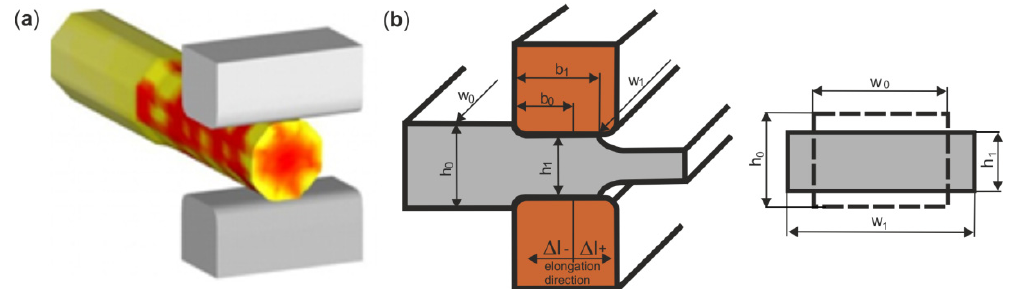
Figure 4. Elongation forging model: ( a ) virtual elongation forging model, ( b ) geometry of elongation forging.